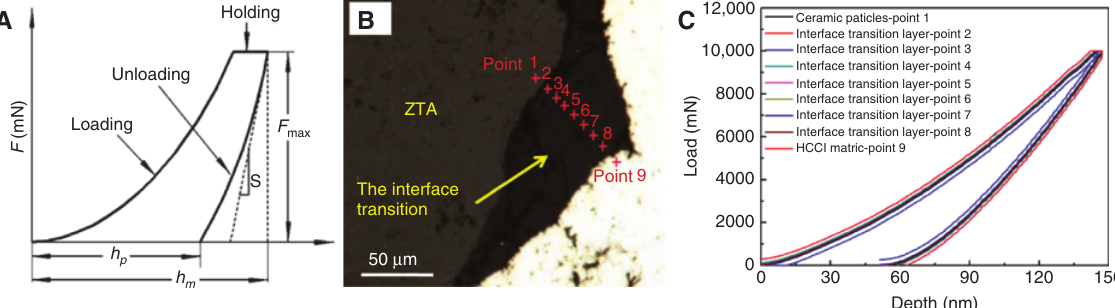
Figure 11: Representative load-displacement ( F - h ) curve analysis based on the Oliver and Pharr method: (A) schematic curve of the nano- indentation test; (B) micrograph of the points load area; (C) nano-indentation load-displacement curves of 1